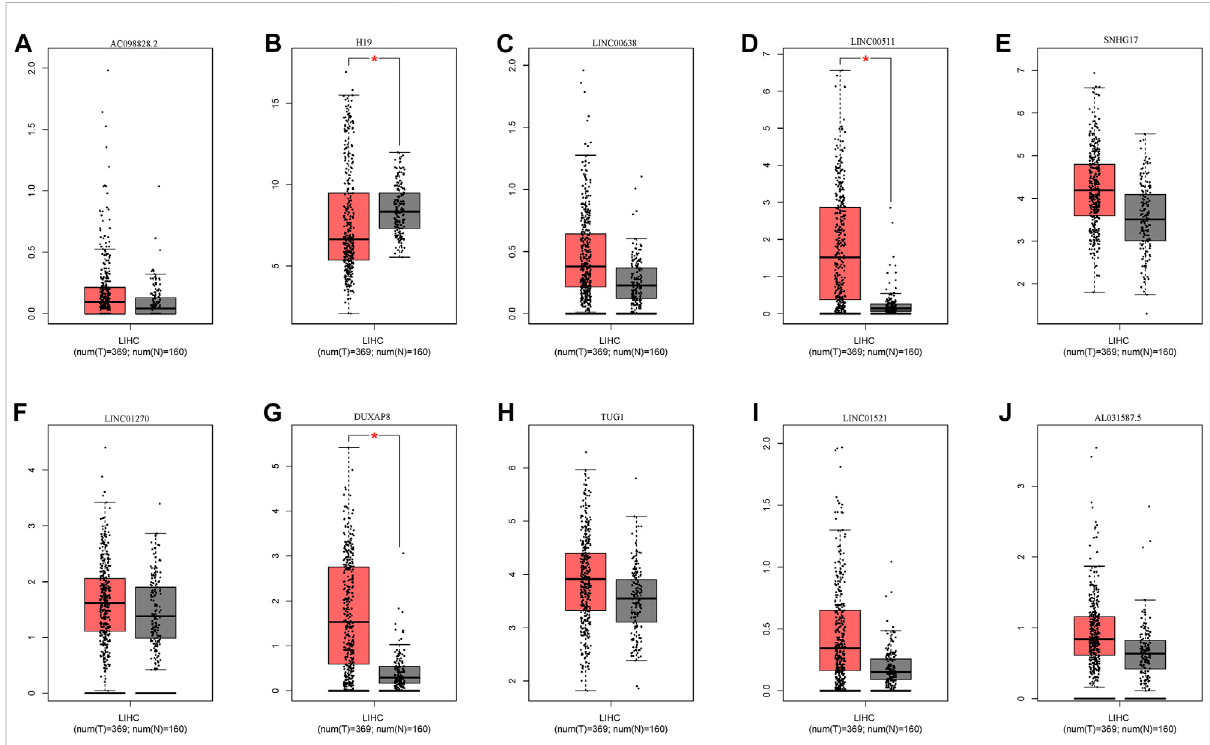
FIGURE 7 Expression of upstream lncRNAs predicted by miR-29c-3p. (A) AC098828.2, (B) H19, (C) LINC0068, (D) LINC0051, (E) SNHG17, (F) LINC01270, (G) DUXAP8, (H) TUGI, (I) LINC01521, (J)